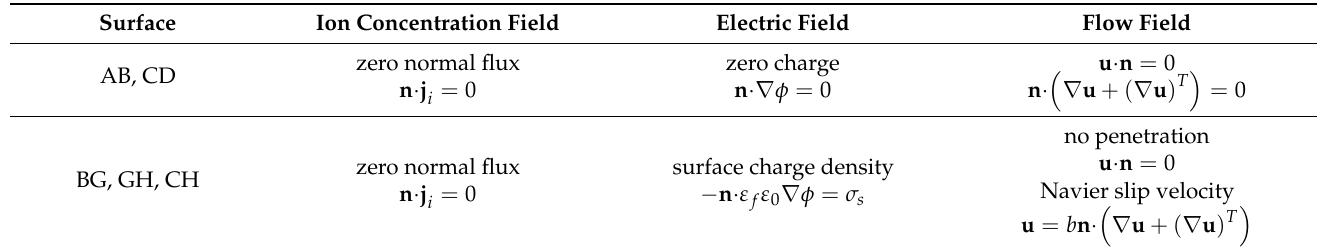
Table 1. Summary of the boundary conditions used in the